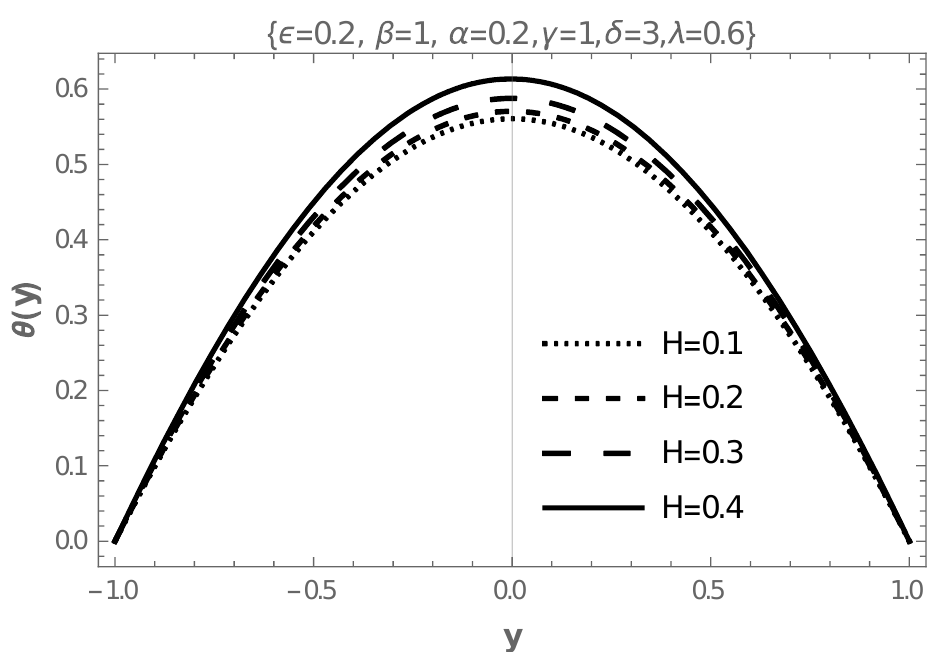
Figure 6. Velocity profile with modified Hartman number ( H) .